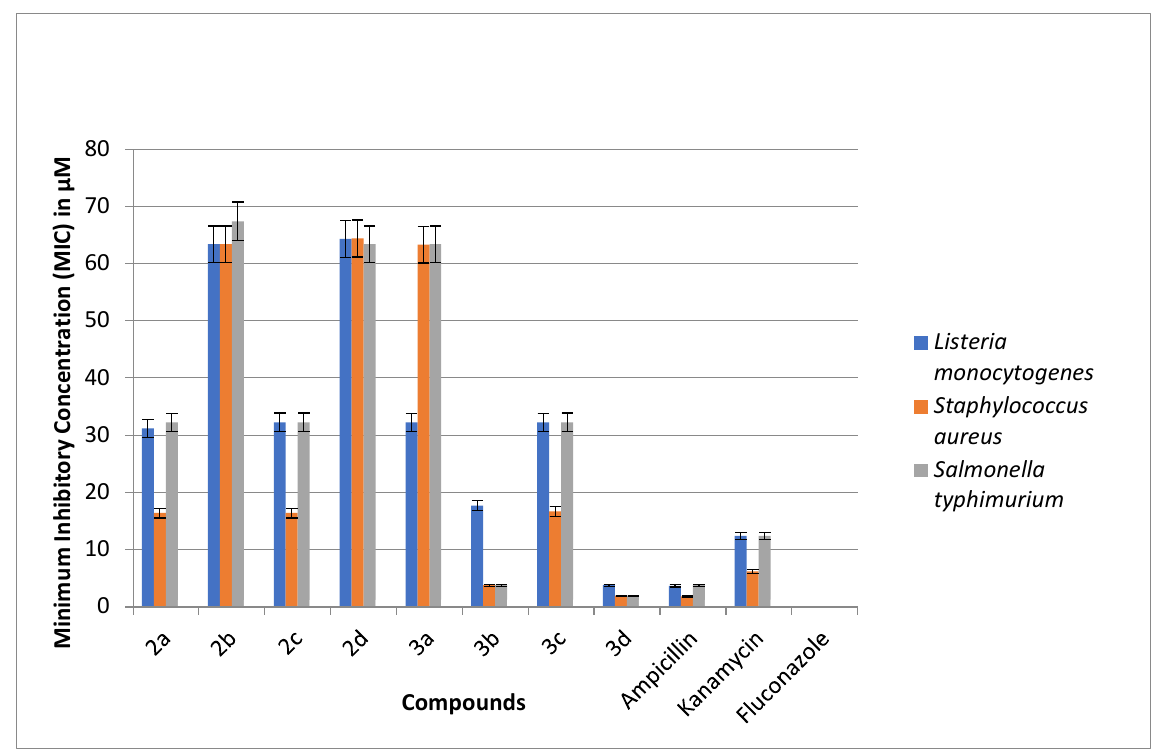
Figure 2. Minimum inhibitory concentration (MIC) of synthesized compounds against L. monocyto- genes , S. aureus and S. typhimurium.